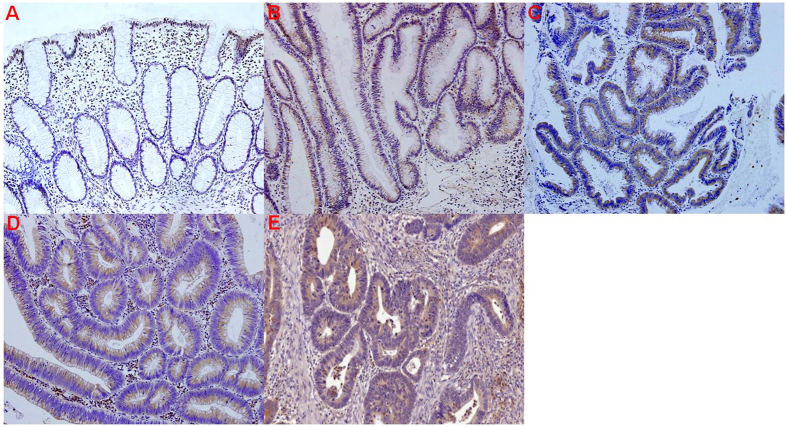
Immunohistochemistry results of MMP-9 in the different clinical groups.(A) Absent or faint MMP-9 staining in the normal colorectal mucosa. MMP-9 immunohistochemical expression was present in the cytoplasm of the neoplastic cells of LSTs and TNM stage I colorectal carcinomas, and staining increased in LSTs with LST progression. (B) Weak MMP-9 expression in low-grade intraepithelial LSTs neoplasia. (C) Moderate MMP-9 expression in moderate intraepithelial LSTs neoplasia. (D) Marked MMP-9 expression in high-grade LSTs intraepithelial neoplasia. (E) Moderate MMP-9 expression in TNM stage I colorectal carcinoma. (original magnification, 200×).